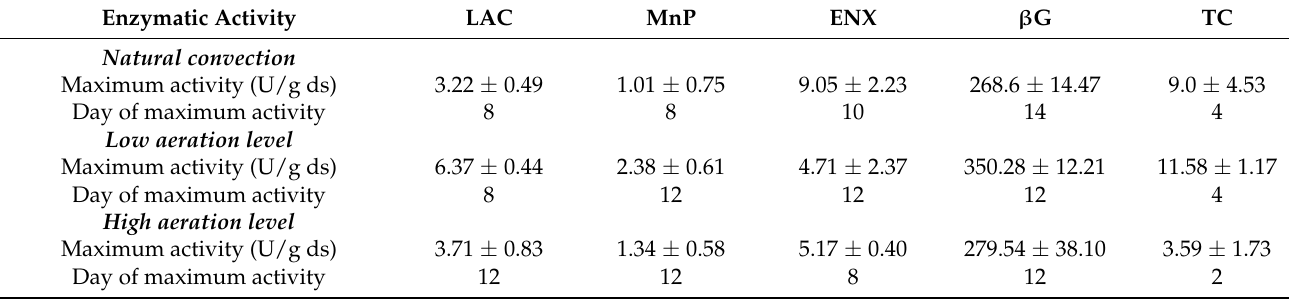
Table 1. Maximum values of enzymatic activities of laccase (LAC), manganese peroxidase (MnP), β -glucosidase ( β G), total cellulases, and β - D -1,4-xylanase (ENX) of T. versicolor cultivated by solid-state fermentation in a fixed-bed pilot-scale bioreactor with natural convection and two levels of forced